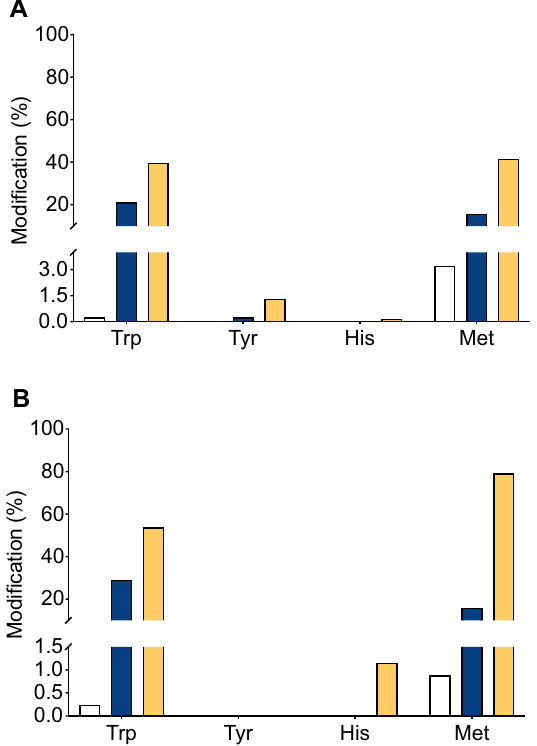
Figure 6. Quantification of the parent amino acids Trp, Tyr, His and Met as detected by LC–MS in G6PDH (54 μM monomer, Panel A ) and 6PGDH (Panel B , 58 μM monomer) after incubation in the absence, or presence, of 10 and 100 mM AAPH at 37 °C for 180 min. The vertical axis indicates the % modification for each residue in the different conditions for control (red), 10 mM AAPH (blue) and 100 mM AAPH (orange) samples. The data are mean values obtained from the analysis of three different replicates prepared on different days. The % modification was calculated considering the full sequence of each protein G6PDH (P0AC53) and 6PGDH (P00350). The data corresponding to the quantification of the % modification of individual residues in the sequence of both proteins, with their respective standard deviations, is available in the Supplementary